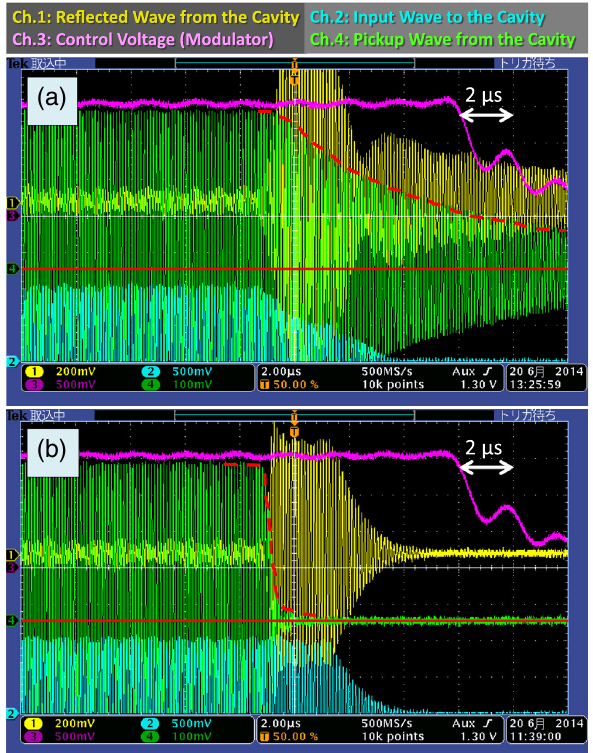
FIG. 6. Waveforms of the oscilloscope displayed for a time span of 20 μ s ( ¼ 2 μ s = div) when the interlock system was activated. The red dashed curves show the envelope of the 508.9-MHz pickup signal from DR cavity No. 2, and the red solid lines show the zero level. (a) Waveforms when the rf switch was turned off for a reason related to the klystron. (b) Example of cavity breakdown events.